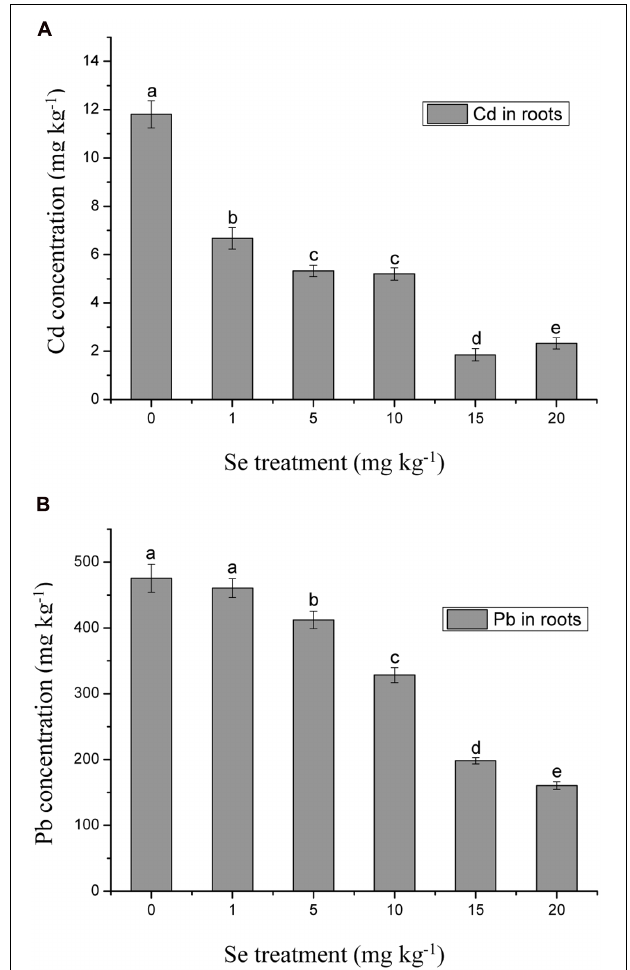
FIGURE 3 | (A) Concentration of Cd in shoots of oilseed rape treated with soil Se and 1 mg kg − 1 Cd in different periods. (B) Concentration of Cd in shoots of oilseed rape treated with soil Se and 5 mg kg − 1 Cd in different periods. Average concentrations (Dry biomass weight, DBW) provided with error bars representing the standard error. ( p ≤ 0.05).